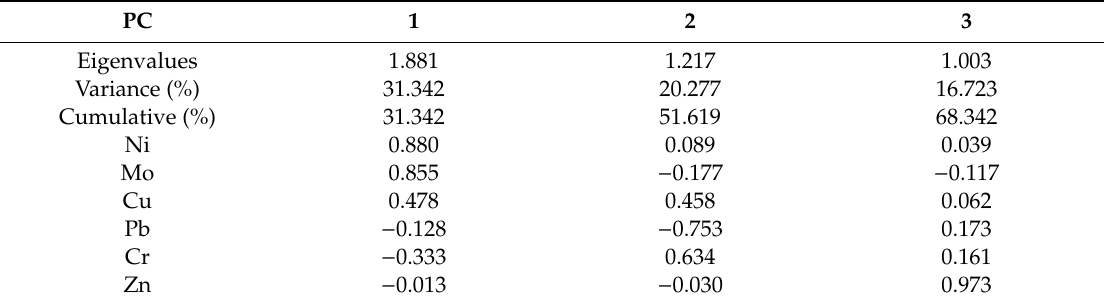
Table 4. Varimax rotated component matrix for the dissolved heavy metals in the Lancangjiang